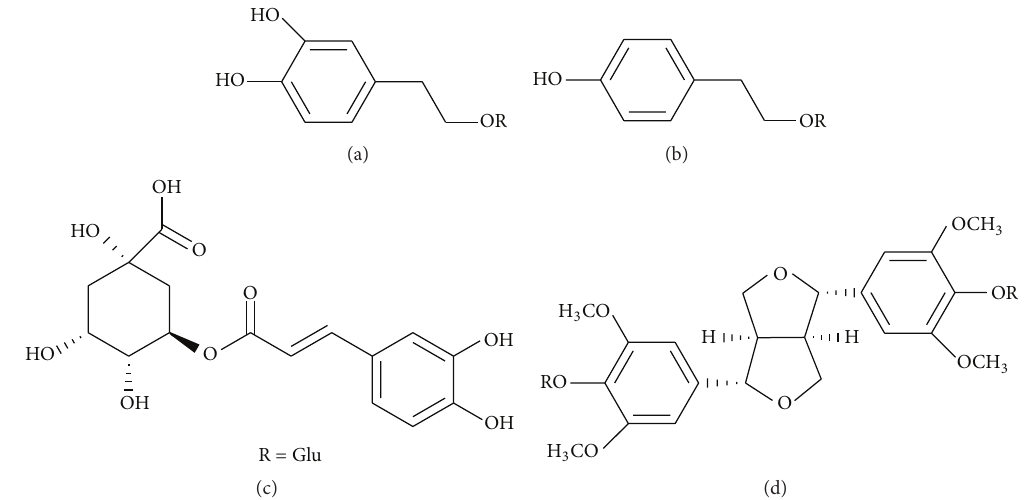
Figure1:Chemicalstructureofthestandardcompoundsinthepresentstudy.(a)3,4-Dihydroxyphenylethylalcoholglycoside;(b)salidroside; (c) chlorogenic acid; (d) liriodendrin.